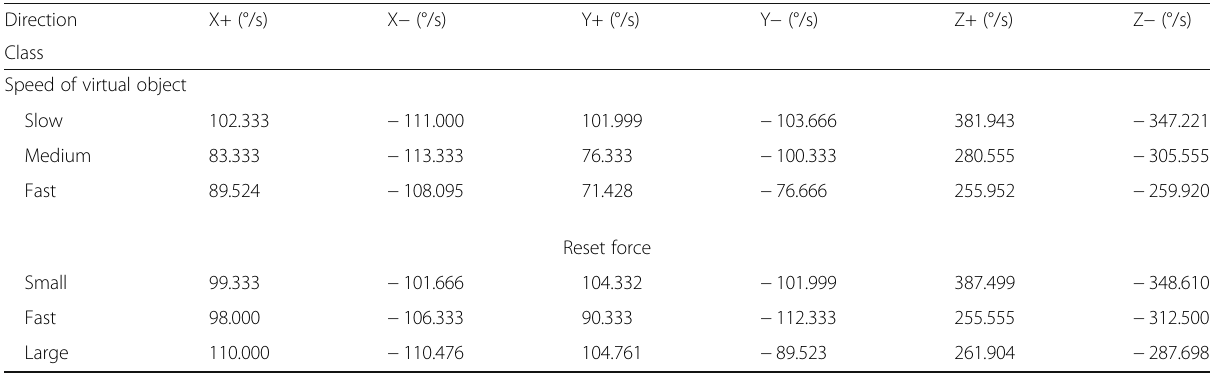
Table 8 Operation speed data